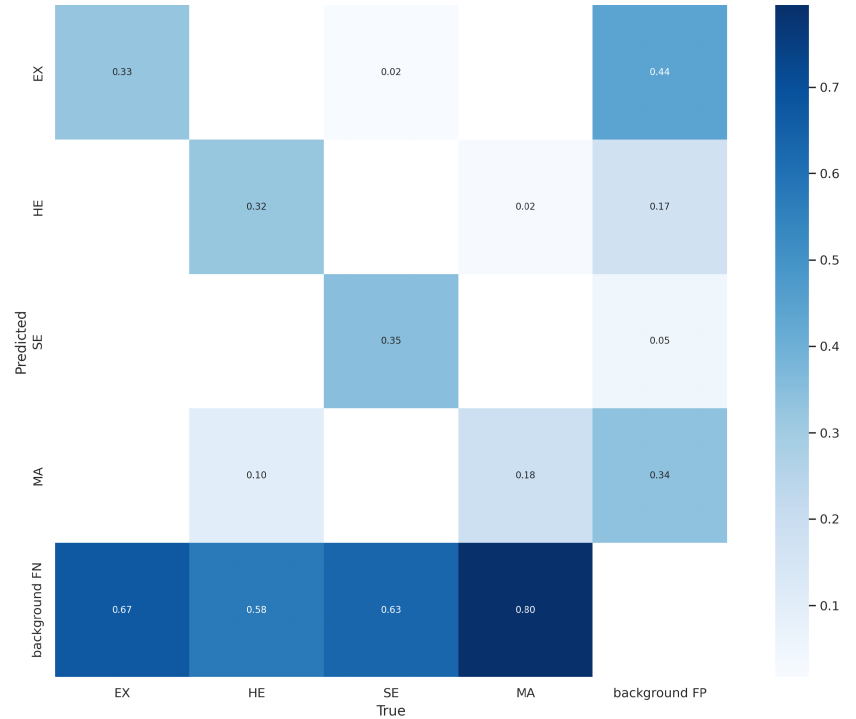
Figure 7. Graph of the Precision × Recall curve with a limit of Intersection over Union of 0.5 obtained during the validation step of the proposed approach with Adam optimizer and Tilling in the Dataset for Diabetic Retinopathy (DDR). EX, hard exudates; HE, hemorrhages; SE, soft exudates; MA, microaneurysms; mAP, mean Average Precision.